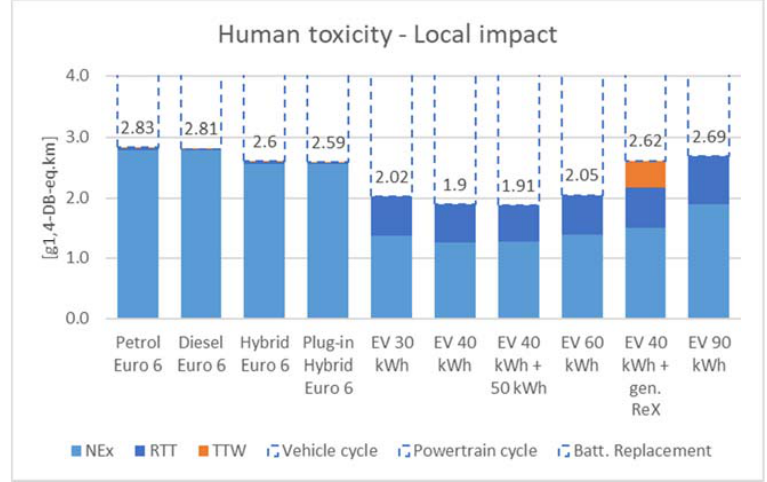
Figure 10. The impact on human toxicity at a local level per powertrain technology, considering refinery-to-tank (RTT) instead of well-to-tank emissions.